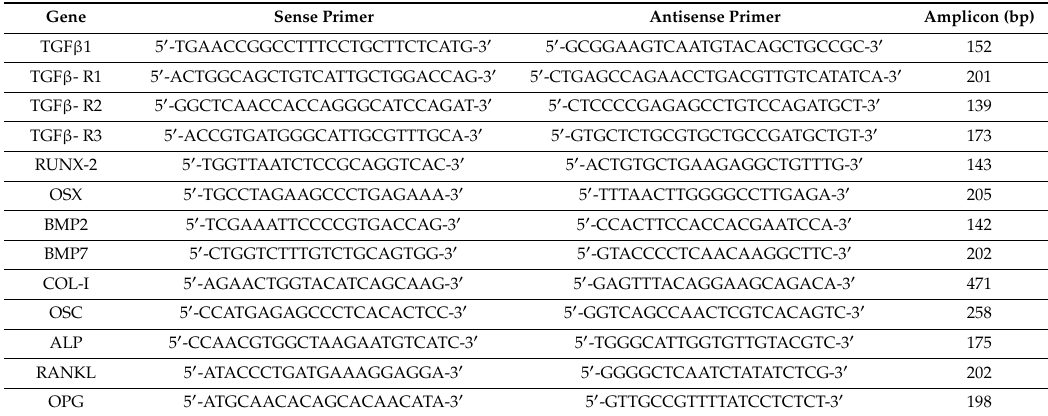
Table 1. Primer sequences for the amplification of cDNA by real-time